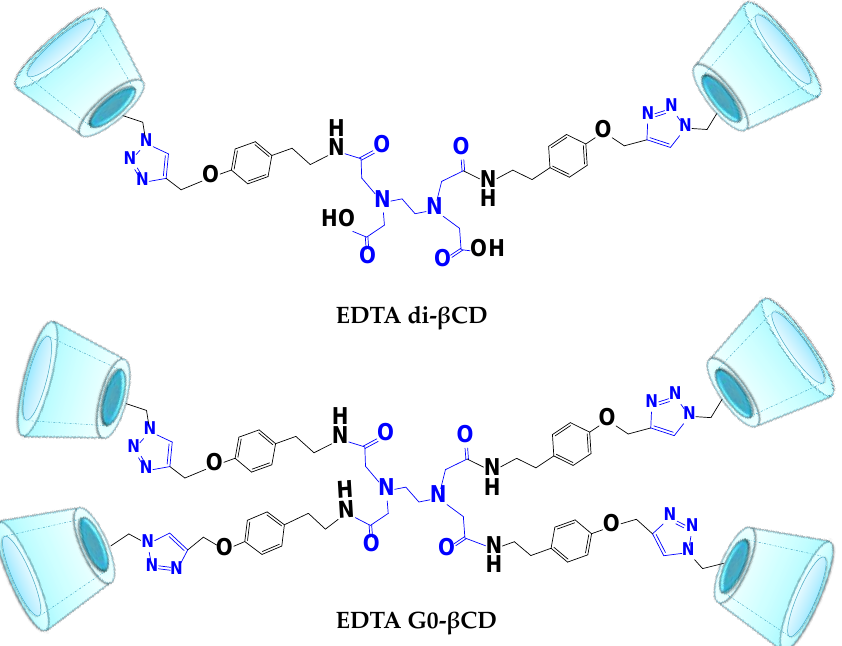
Figure 1. Schematic representation of the dendritic EDTA di- βCD and EDTA G0- βCD dendrimer molecules.